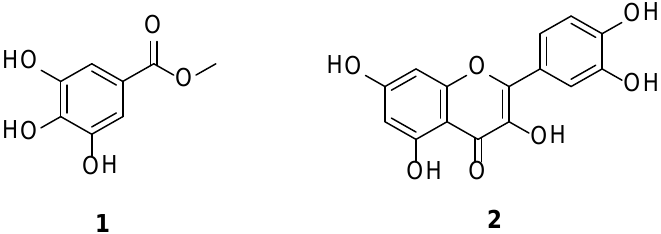
Figure 2. Chemical structures of the isolated methyl gallate ( 1 ) and quercetin ( 2 ).